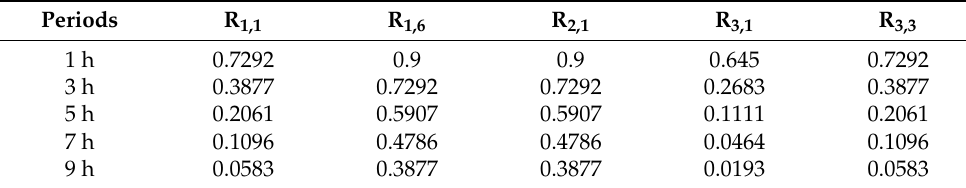
Table 9. Reliability for the component–subsystem relationships during five time periods from 25 to